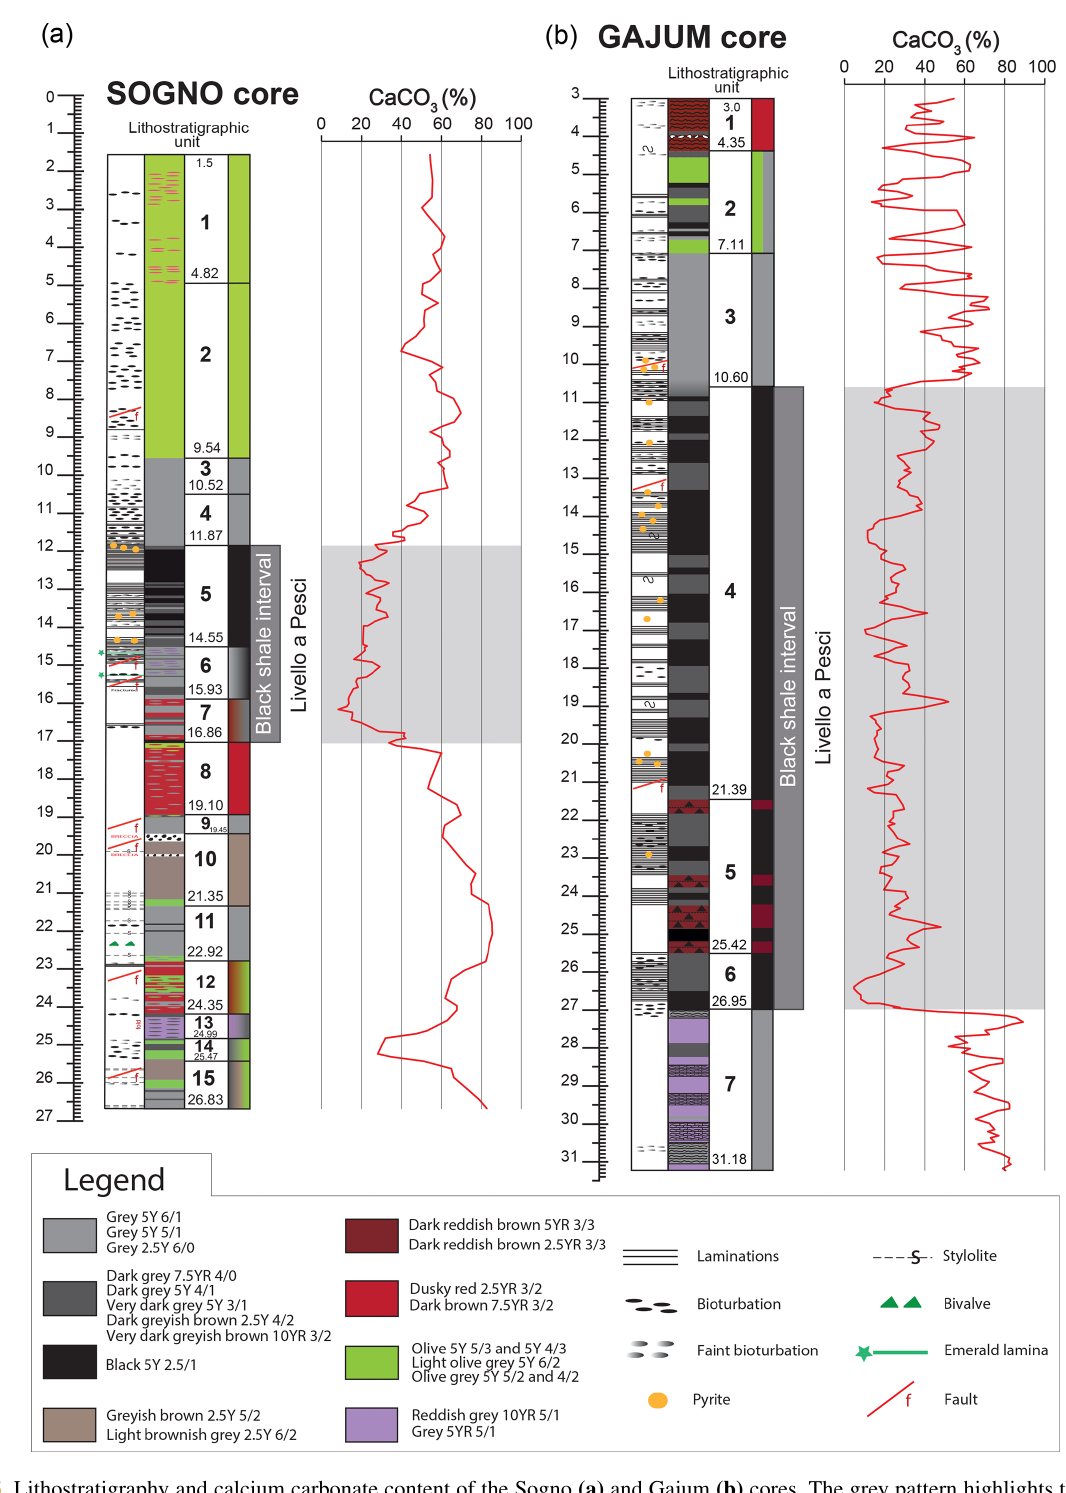
Figure 5. Lithostratigraphy and calcium carbonate content of the Sogno (a) and Gajum (b) cores. The grey pattern highlights the Livello a Pesci black shale interval that is the lithostratigraphic record of the T-OAE in the Lombardy Basin. The CaCO 3 content was detected using the Dietrich-Frühling gas volumetric method by measuring evolved CO 2 after acidification of the bulk sample with